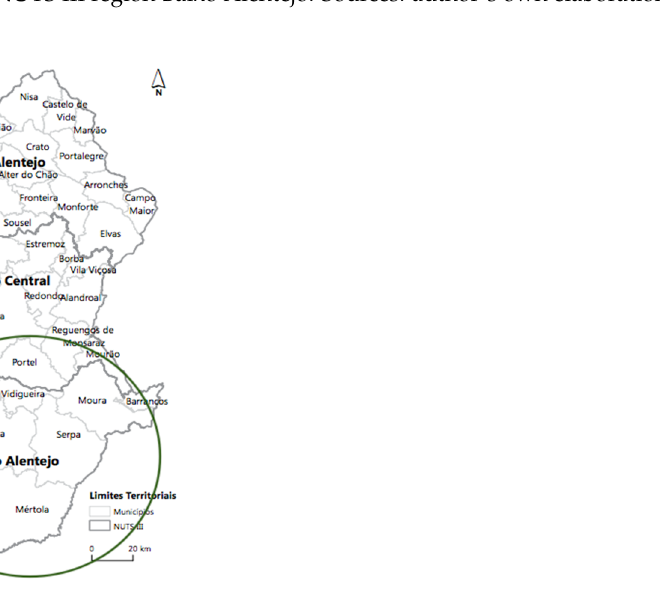
Figure 4. Map of the municipalities of NUTS II region of Alentejo, highlighting municipalities of Baixo Alentejo. Sources: author’s own elaboration based on INE (2021).